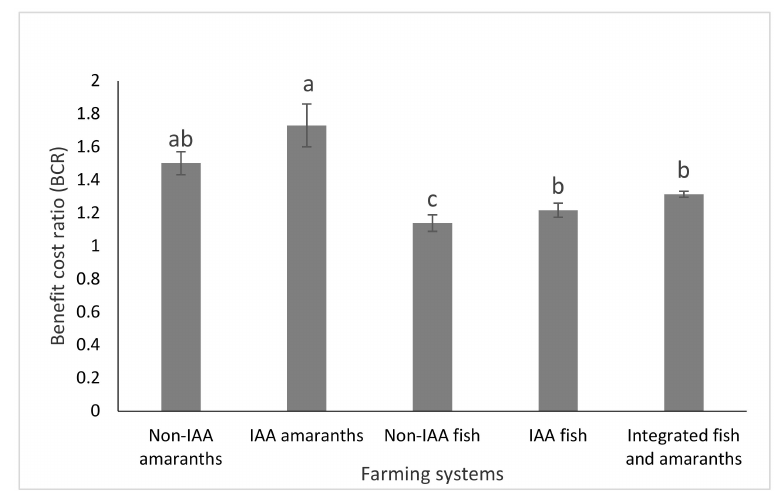
Figure 6. Benefit cost ratio of tilapia and amaranth farming when conducted as integrated and non-integrated farming (bars with di ff erent letters are significantly di ff erent, p < 0.05). (Bars represent means ± SE).